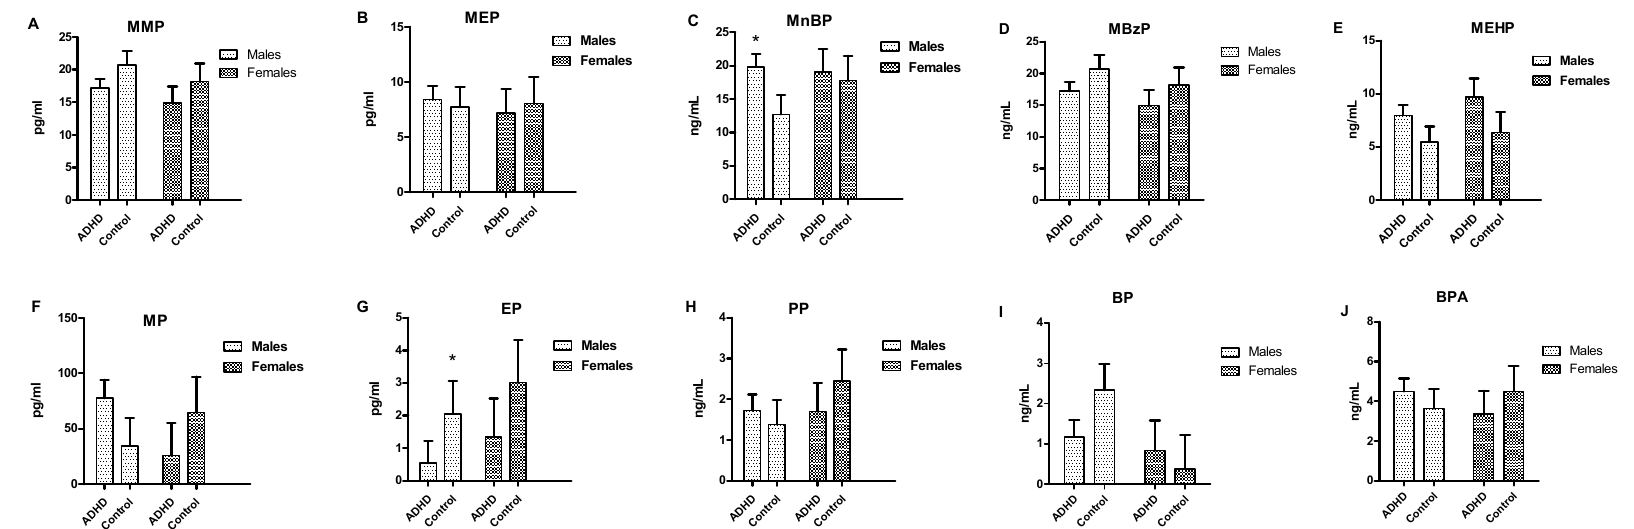
Figure 1. Serum levels of endocrine-disrupting chemicals (EDCs) in boys and girls among patients with ADHD and controls * p < 0.05.